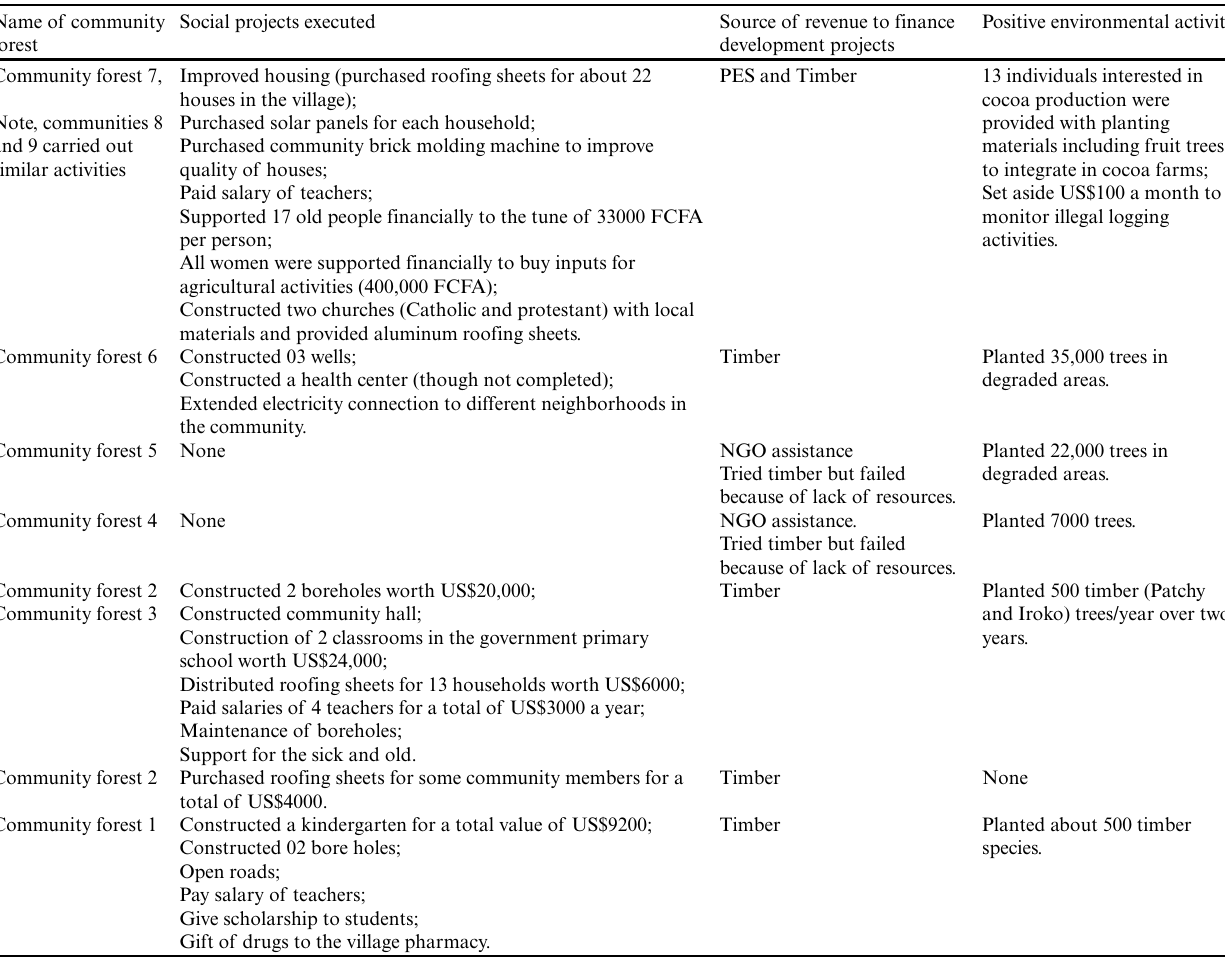
Table 1 . Case study community forests and their social and environmental